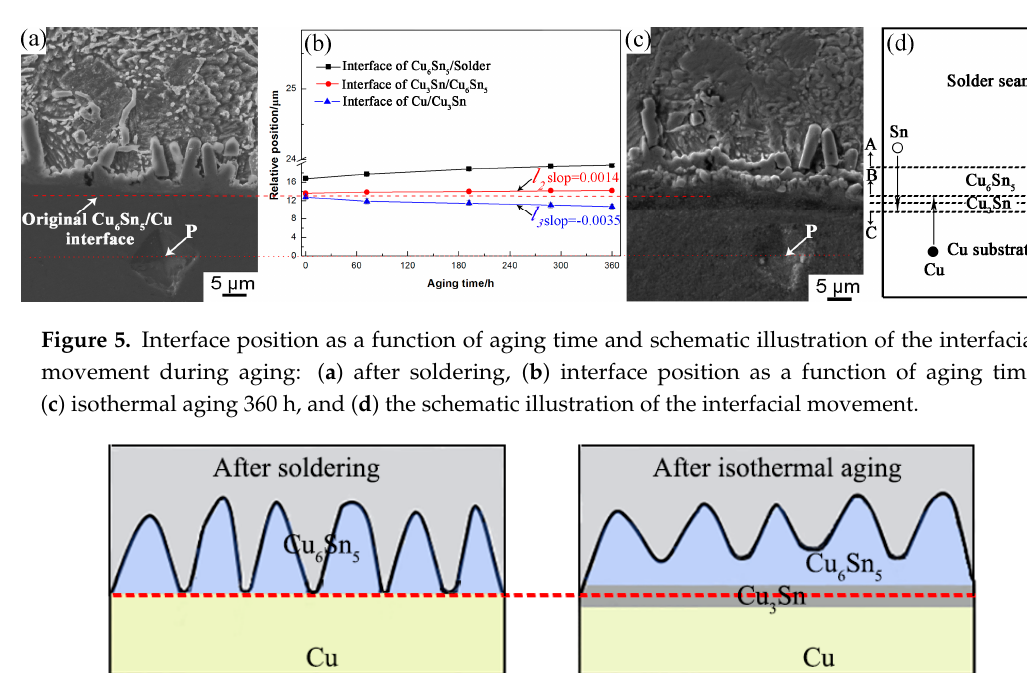
Figure 6. Schematic illustration of the interfacial IMC during isothermal aging.